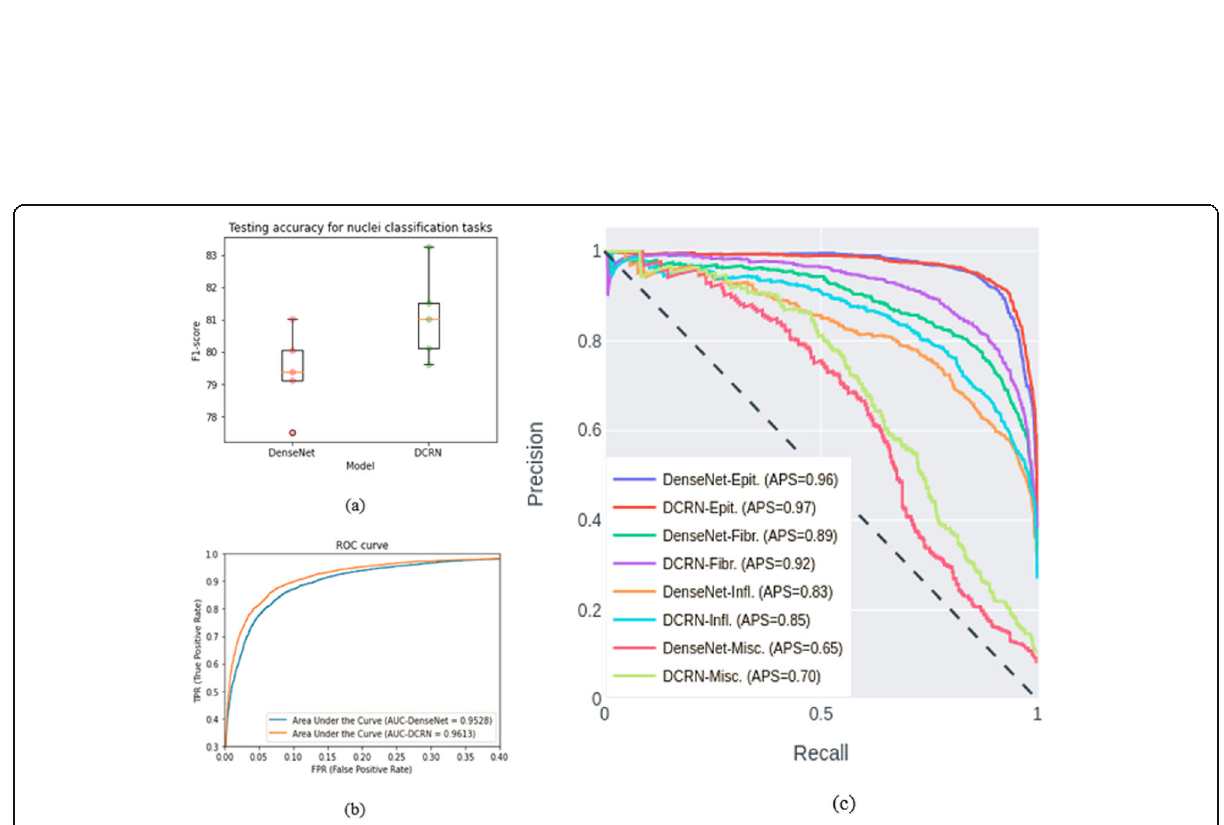
Fig. 10 Results for nuclei classification model. a Box plot for testing F1-score. b Area under the ROC curve with average AUC and (b) precision- recall curve with Average Precision Score (AVS) of the DenseNet and DCRN models for nuclei classification